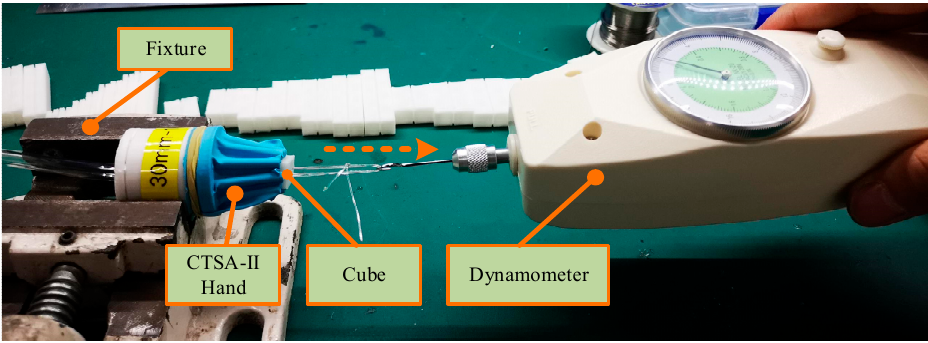
Figure 21. The experiment of measuring the grasping force.